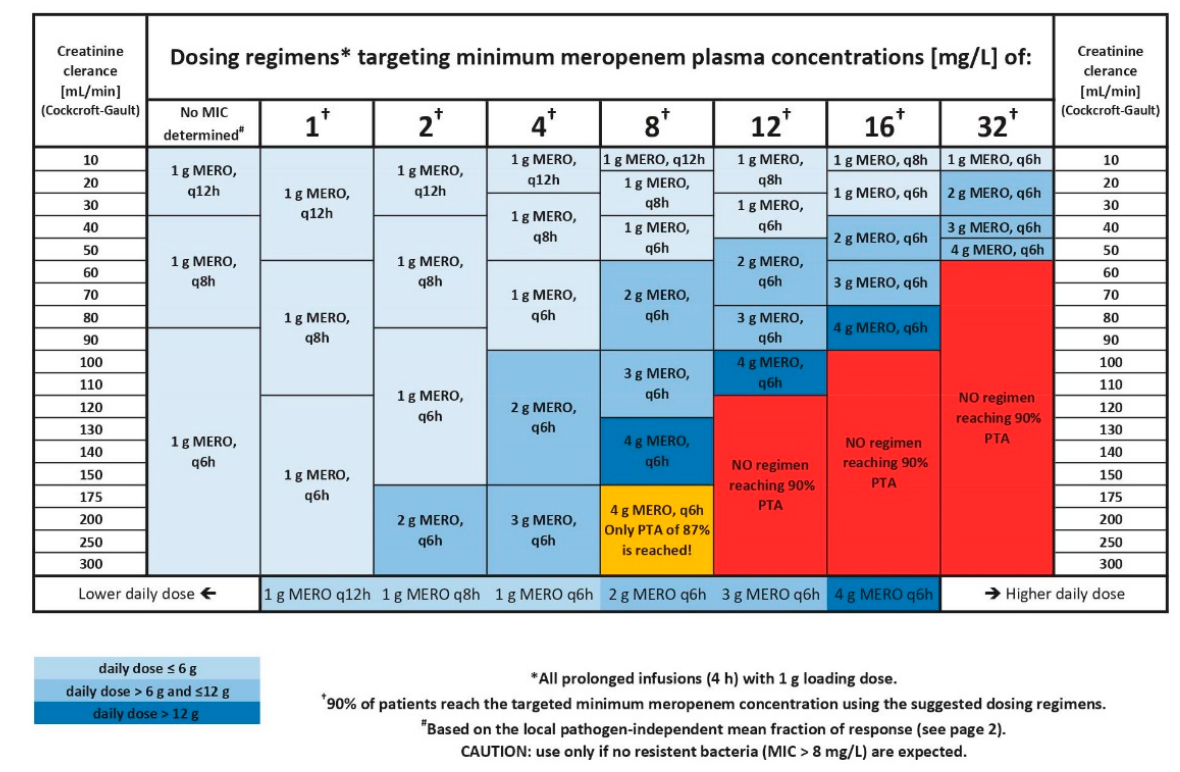
Figure 3. Front page of the developed dosing decision tool for initial meropenem dosing in intensive care patients. Dosing recommendations are stratified for creatinine clearance according to Cockroft and Gault and target (minimal meropenem concentration or local pathogen-independent mean fraction of response (LPIFR), see text) MERO: meropenem; q6h: every 6 h dosing; q8h; every 8 h dosing; q12h: every 12 h dosing; PTA: probability of target attainment; MIC: minimal inhibitory concentration.